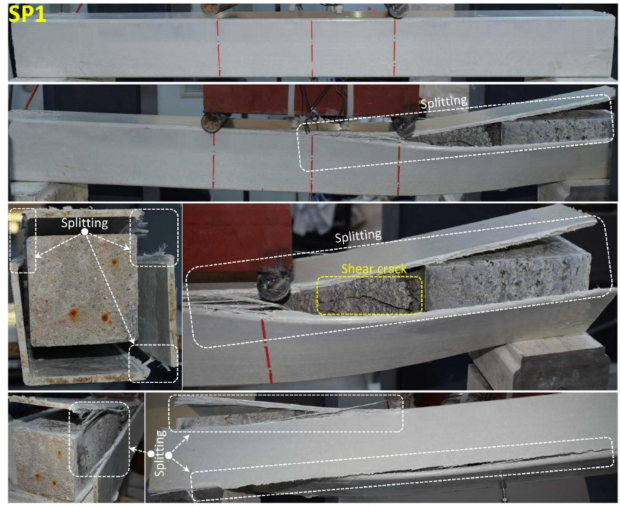
Figure 10. Undamaged and damaged specimen images of SP1.